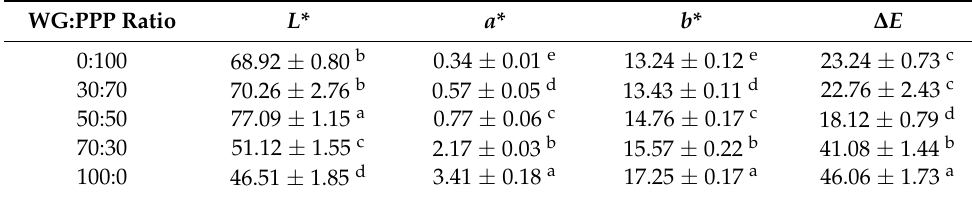
Table 7. Color of extrudates with different mixing